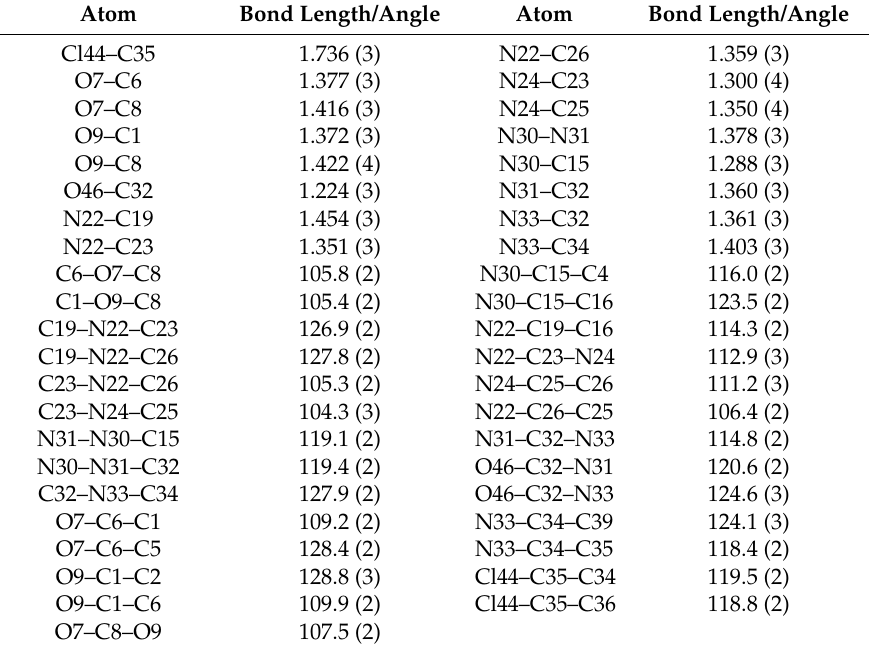
Table 2. Geometric parameters (Å, ◦ ) of the semicarbazone 4 .